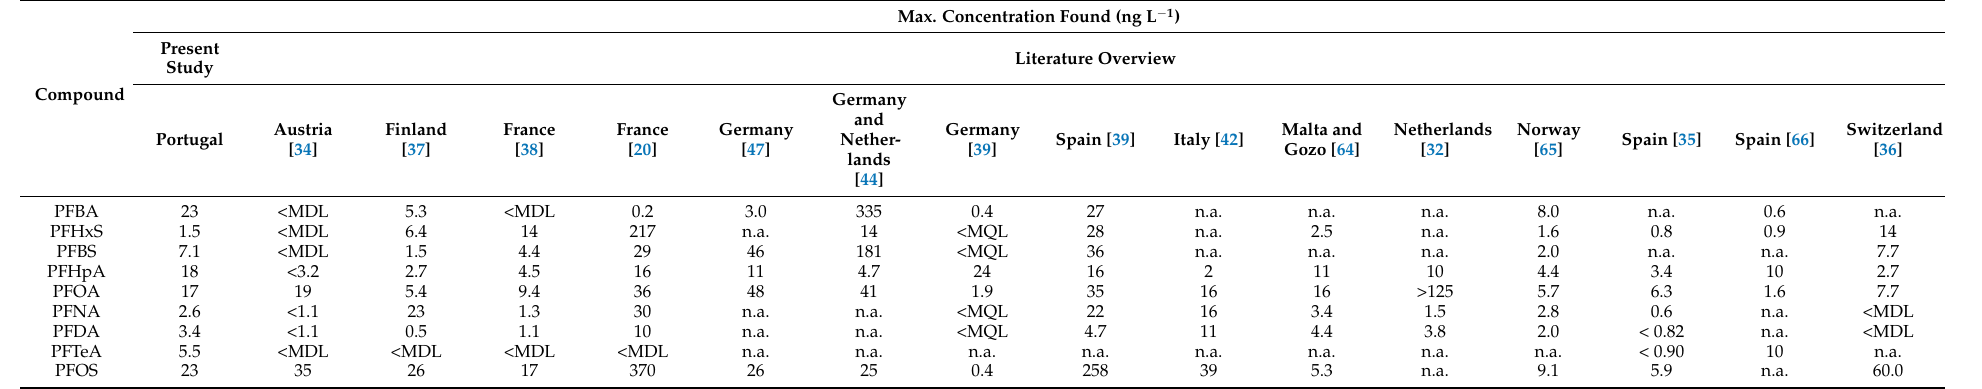
Table 2. Comparison of occurrence data for the targeted PFASs in SW samples (ng L − 1 ) from this study with previous reports in